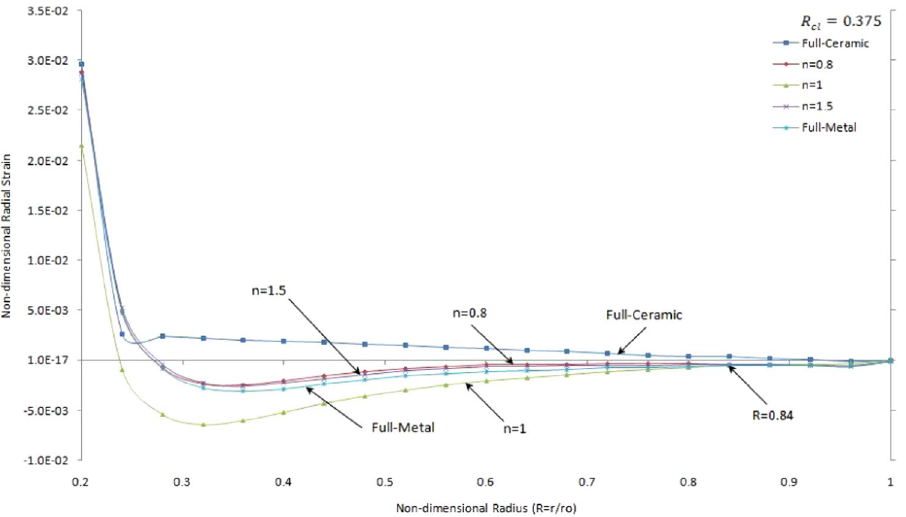
Figure 14. Non-dimensional redial strain versus the non-dimensional radius of two side contacts with temperature-dependent material properties under thermo-mechanical loads in the FGMs rotating brake disk with R cl = 0.375 and different values of the grading index,